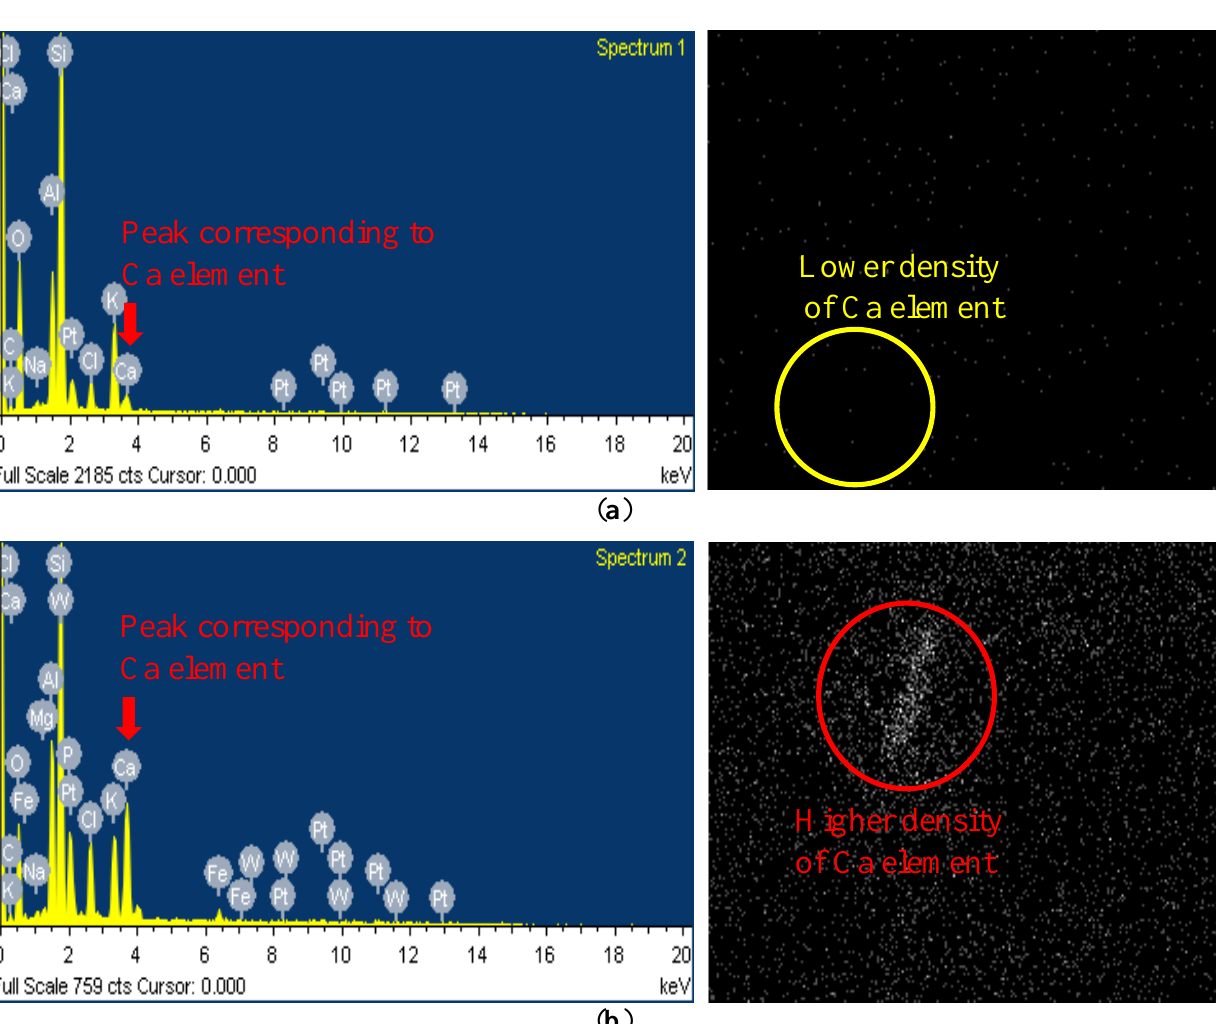
Figure 5. Energy dispersive X-ray (EDX) and mapping analysis (the magnified image is 5000 times larger than its original scale) results of specimens with ( a ) minimum Ca element observation (well-graded weathered soil specimen) and ( b ) maximum Ca element observation (poorly-graded weathered soil